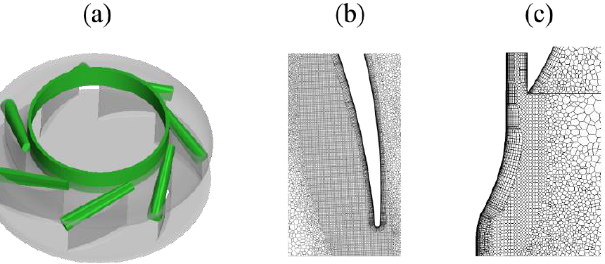
Figure 4. ( a ) The mesh refinement regions, colored green. Volume mesh cells near: ( b ) the blade trailing edge and ( c ) the inlet gap. Table 2. The mesh parameters.